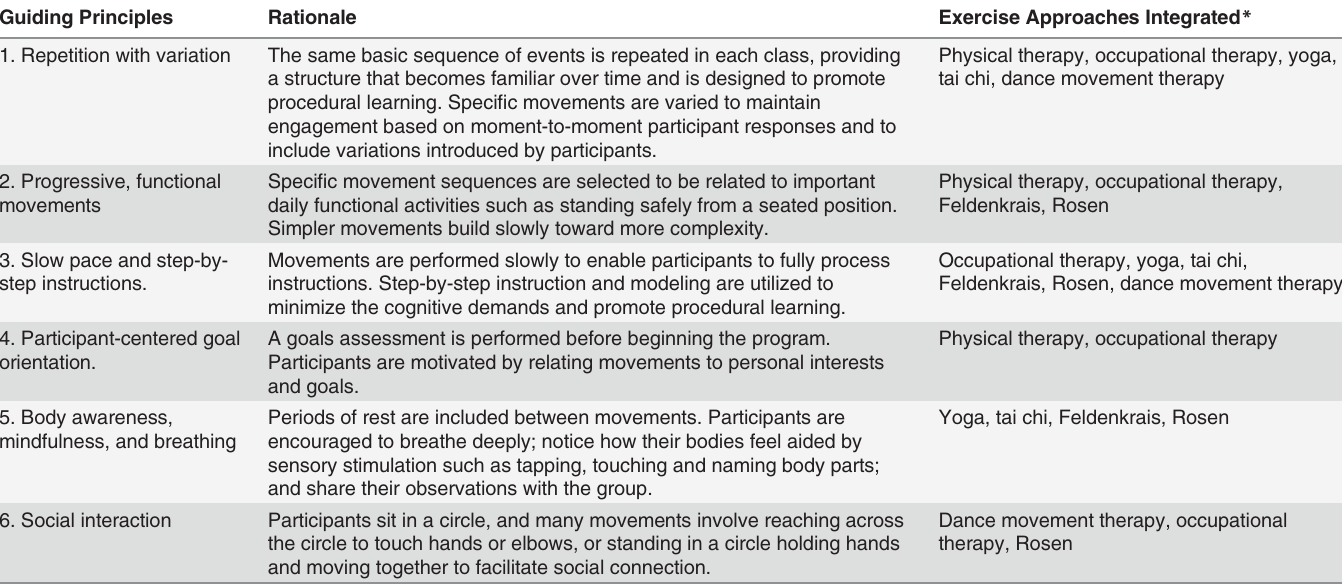
Table 1. Preventing Loss of Independence through Exercise (PLIÉ) Guiding Principles. Guiding